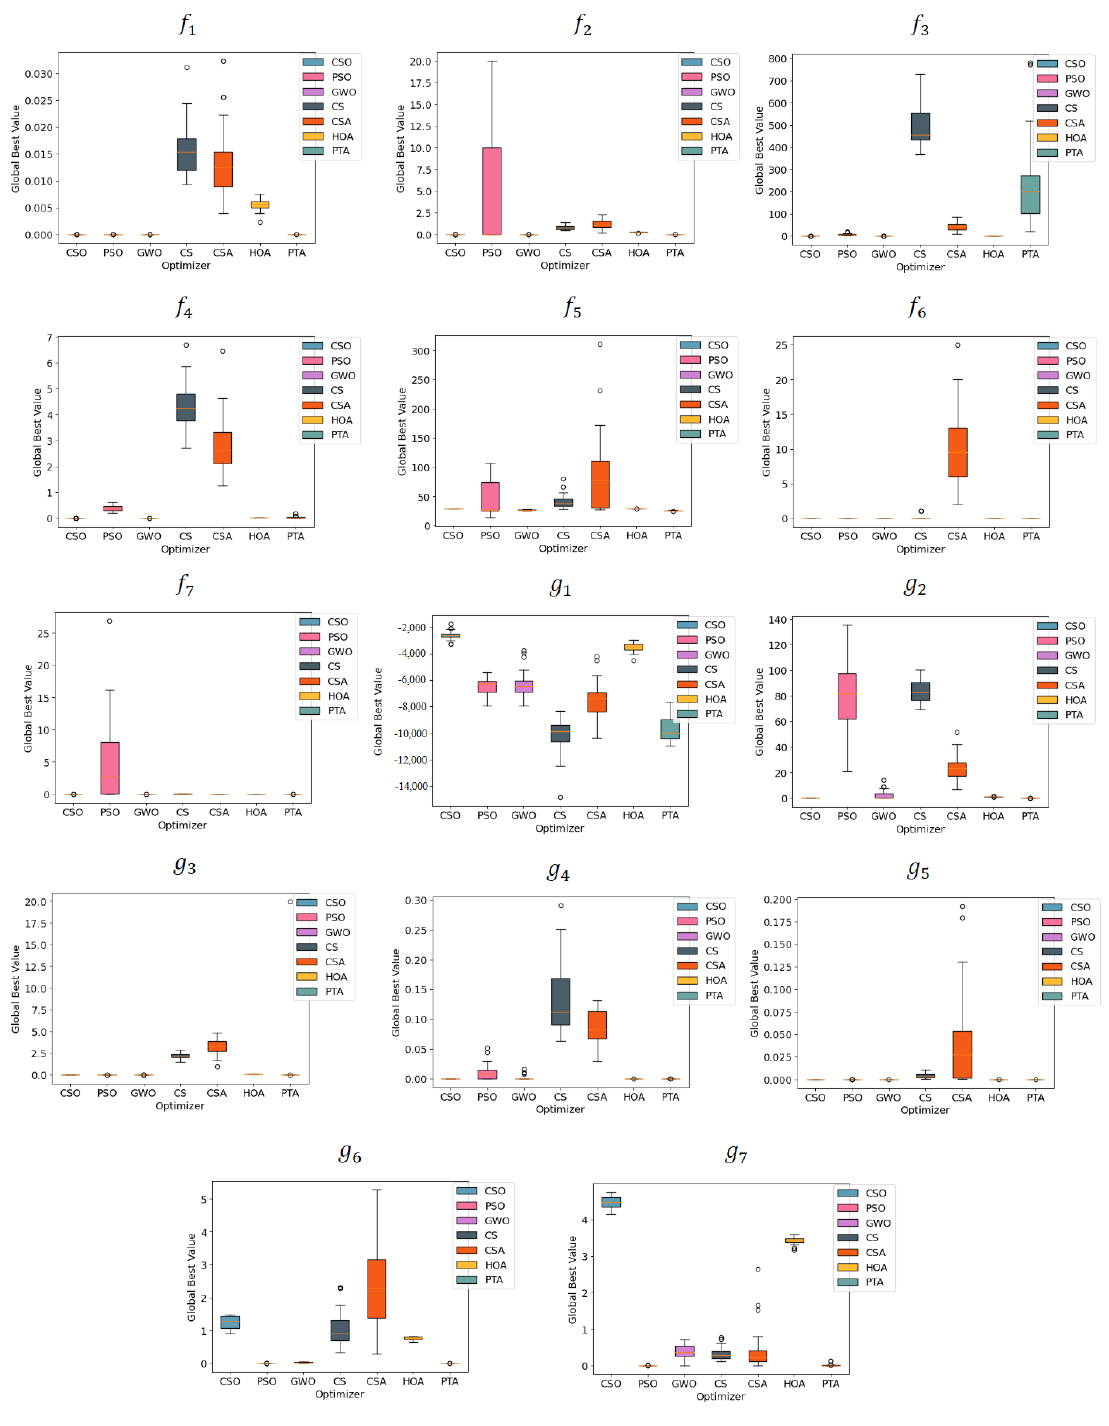
Figure 4. Boxplot Charts for the Objective Functions 𝑓 1 − 𝑓 7 and 𝑔 1 − 𝑔 7 .